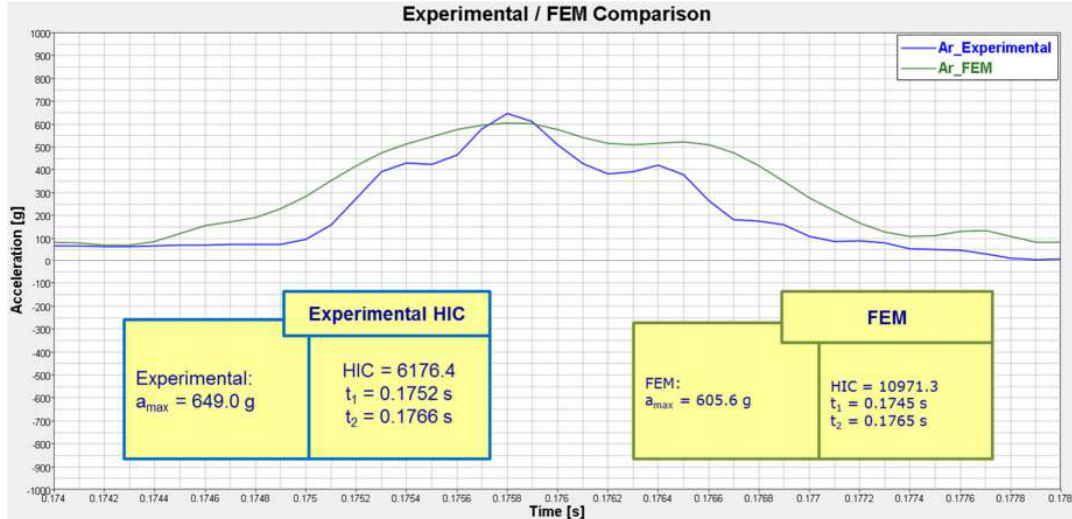
Figure 6. Experimental-numerical Head Injury Criterion (HIC) comparison.